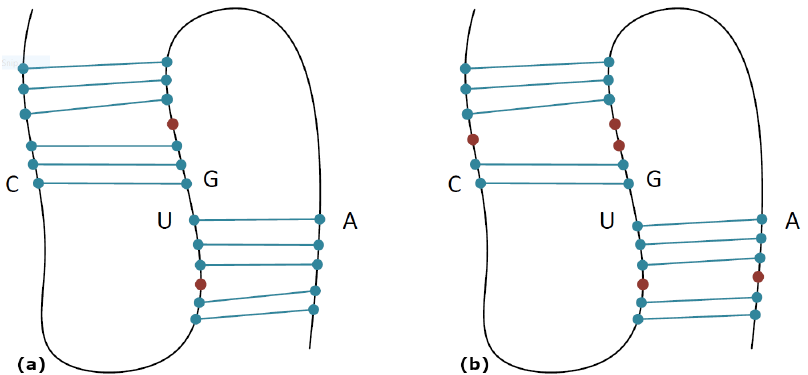
Figure 2. H-type pseudoknots with bulges ( a ) and internal loops ( b ). Unpaired bases forming a bulge or internal loop are represented with red